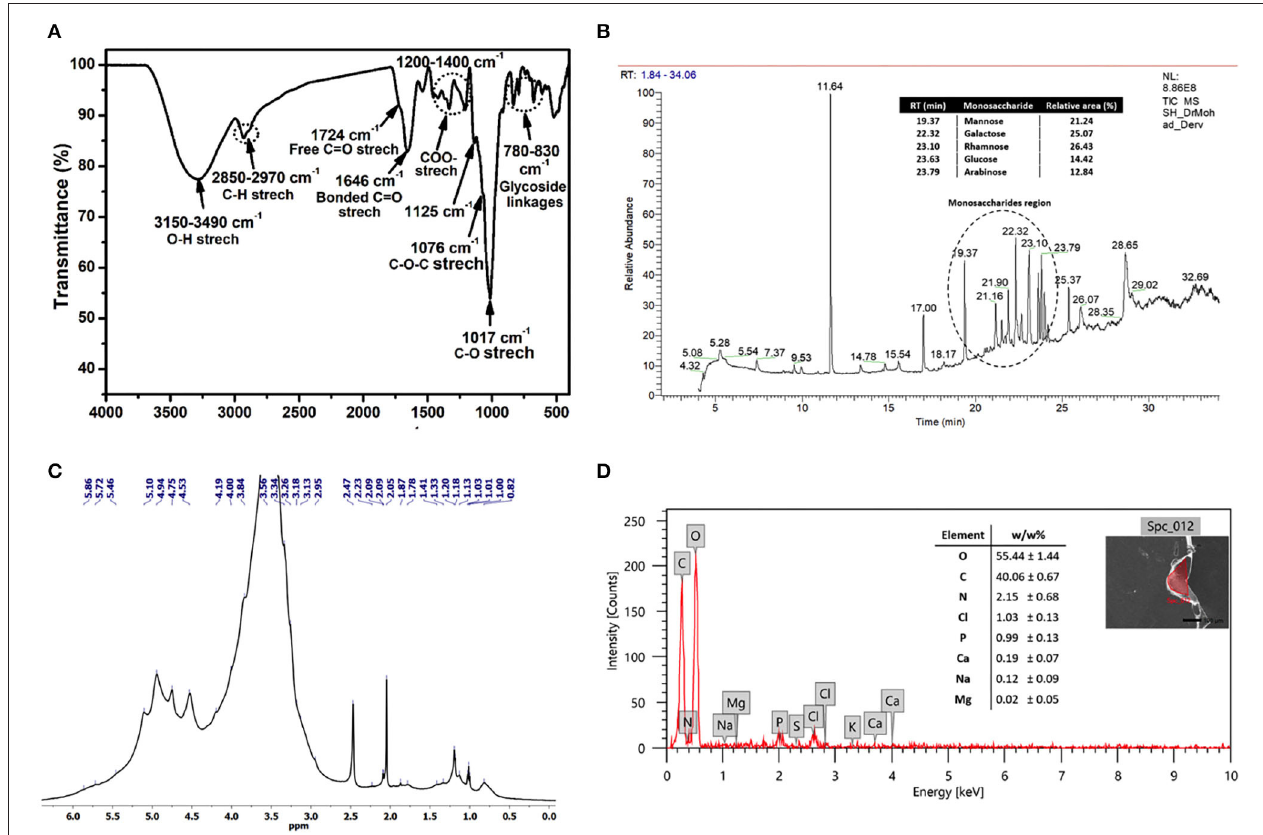
FIGURE 3 | FTIR spectrum (A) , GC-MS chromatogram (B) , 1 H NMR spectrum recorded at 323K (2.0% w/v; DMSO- d 6 , 500 MHz) (C) , and SEM-EDX data of the produced exopolysaccharide (EI6-EPS) (D)